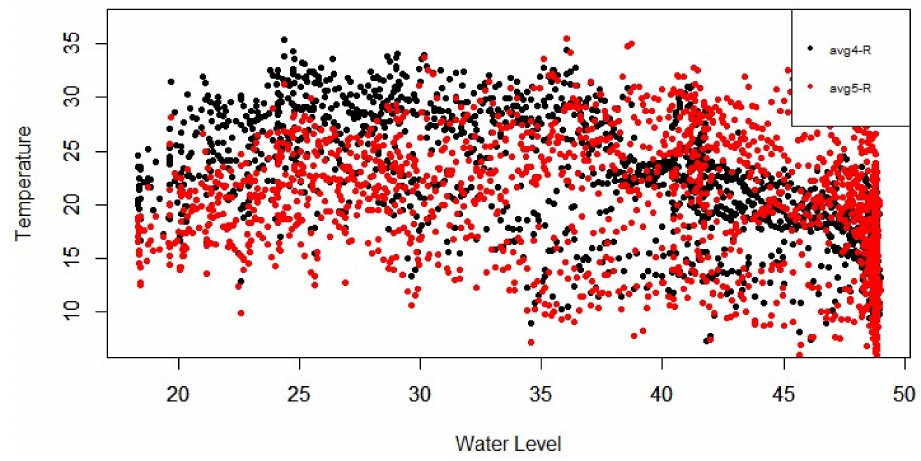
Figure 22. Water level (m) against avg4-R and avg5-R water temperatures ( ◦